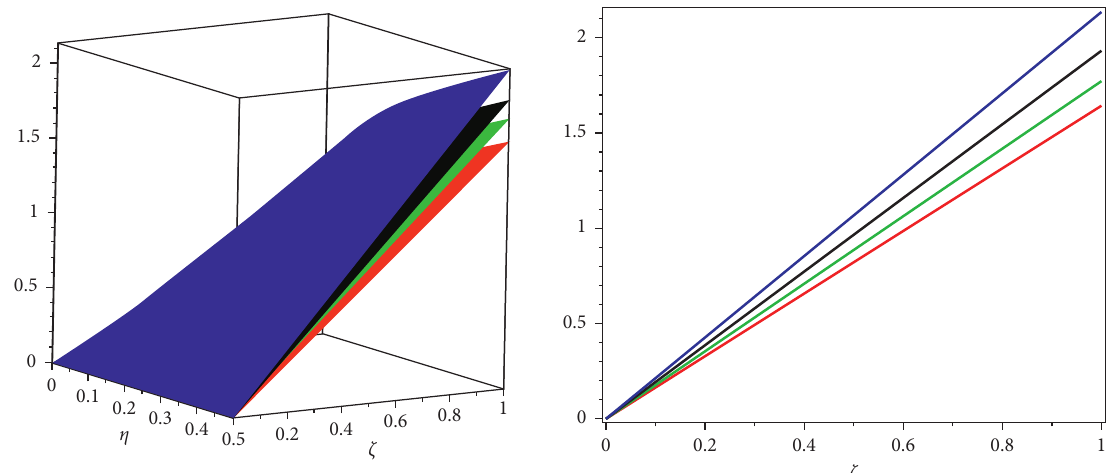
Figure 3: The approximate result graph of problem 4.1, at different fractional-order of δ